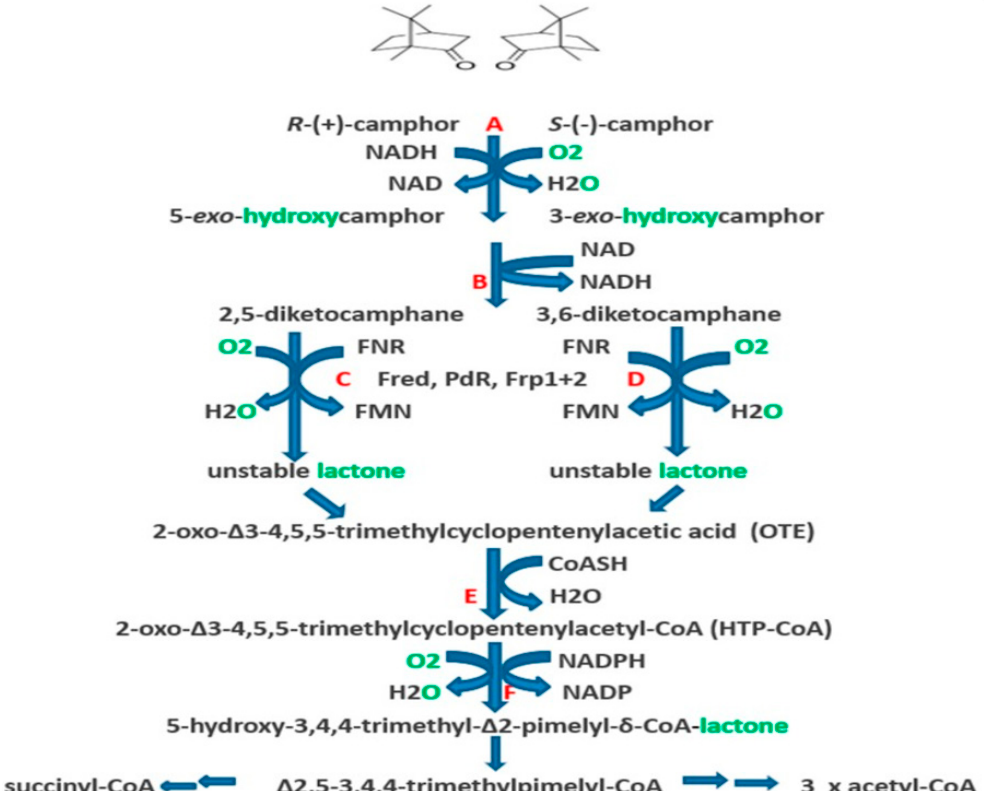
Figure 1. Pathway of (+)- and ( − )-camphor degradation in P. putida ATCC 17453. A = cytochrome P450 monooxygenase ( camCAB ): B = exo -hydroxycamphor dehydrogenase ( camD ): C = 2,5-diketocamphane 1,2-monooxygenase ( camE 25-1 + camE 25-2 ): D = 3,6-diketocamphane 1,6-monooxygenase ( camE 36 ): E = 2-oxo- ∆ 3 -4,5,5-trimethylcyclopentenylacetyl-CoA synthetase ( camF 1 + F 2 ); F = 2-oxo- ∆ 3 -4,5,5-trimethylcyclopentenylacetyl-CoA monooxygenase ( camG ): FNR = reduced flavin mononucleotide: Fred = 36 kDa chromosome-coded flavin reductase: PdR = putidaredoxin reductase subunit of cytochrome P45O monooxygenase ( camA ): Frp 1 + 2 = chromosome-coded ferric reductases: diatomic oxygen molecules participating in the four monooxygenase-catalysed steps is shown in green, as in each case are the fates of each component oxygen atom.